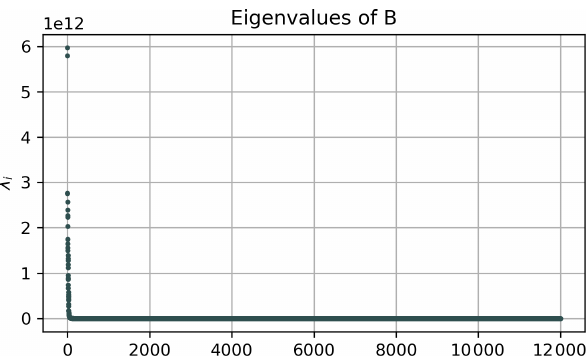
Figure A1. Spectrum of the classical MDS kernel matrix B for the Bickley jet flow. It is evident that there are two dominant eigenvalues. We choose the vectors corresponding to these first two eigenvalues as embedding vectors in Sect. 4.1.